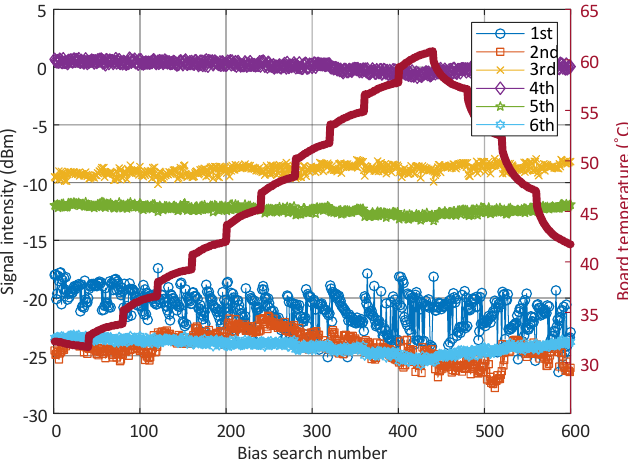
Figure 5. Intensity of the generated signals for each